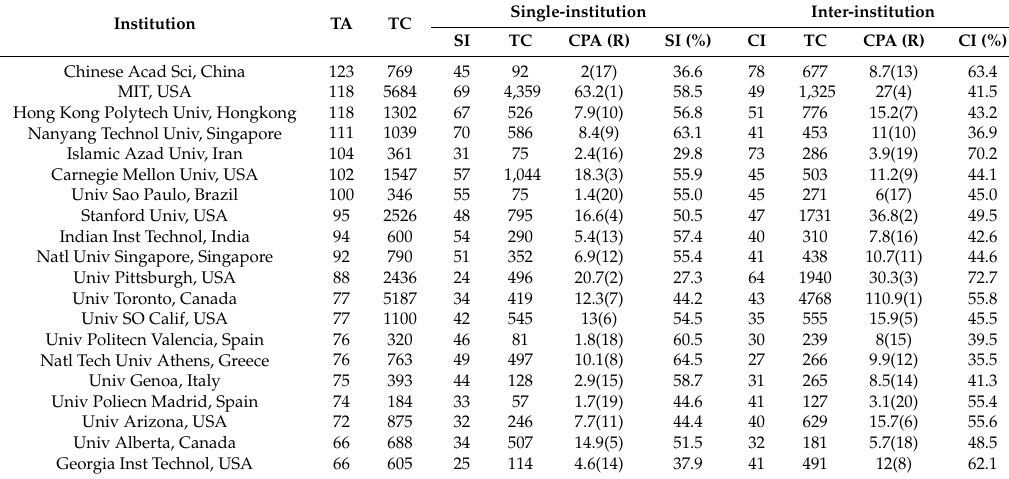
Table 5. Top productive institutions in artificial intelligence